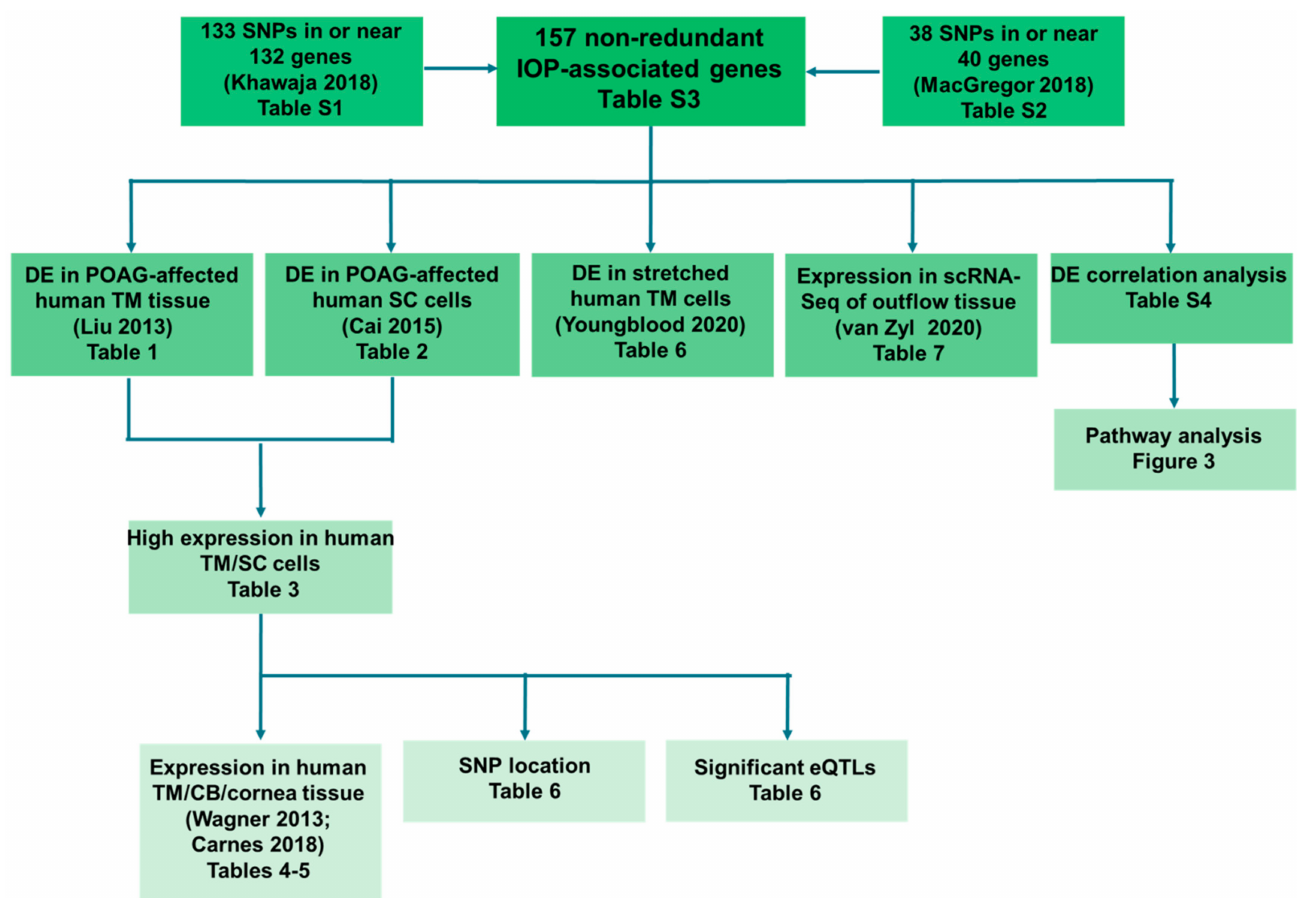
Figure 1. Experimental design for prioritization of intraocular pressure (IOP) associated genes. From two previously published genome-wide association studies (GWAS) [24,25], we identified 157 non-redundant IOP-associated genes, which we filtered and characterized for future functional analysis using the following criteria: (1) differential expression (DE) in primary open-angle glaucoma (POAG) affected trabecular meshwork (TM) tissue, (2) DE in POAG-affected Schlemm’s canal (SC) cells, (3) high expression in non-glaucomatous human TM and/or SC cells, (4) significant/high expression in human TM, ciliary body (CB), and cornea tissue, (5) single nucleotide polymorphism (SNP) location in regulatory regions, (6) significant expression quantitative trait loci (eQTL) for gene/SNP pairs, (7) DE in cyclically stretched human TM cells, (8) specific expression in cell clusters defined by single-cell RNA-sequencing (scRNA-Seq) of human conventional outflow tissue, and (9) pathway analysis of differential correlation